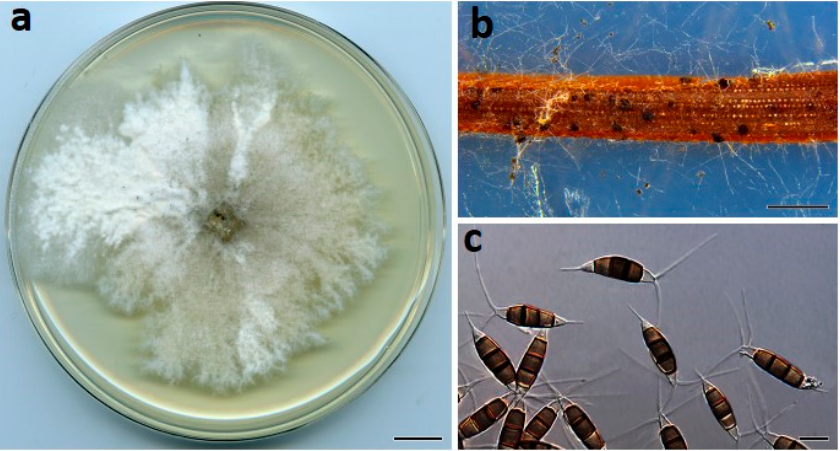
Figure 7. Neopestalotiopsis zakeelii (BRIP 72282a). ( a ) Two-week-old colony on PDA, ( b ) conidiomata on pine needle agar, and ( c ) conidia. Scale bars: a = 1 cm; b = 1 mm; c = 10 µm. MycoBank: MB840920.